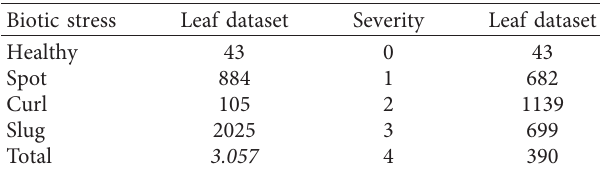
Figure 2: Examples of pear leaves affected by different symptoms. Table 1: Dataset details. It presents the number of images for each biotic stress and